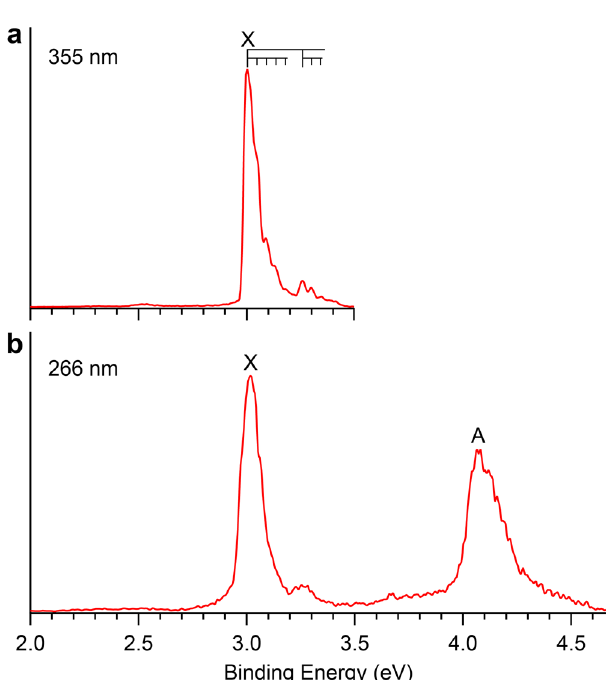
Fig. 2 Photoelectron spectra of PbB 3 O 2 – . a At 355 nm. b At 266 nm. The vertical lines represent resolved vibrational